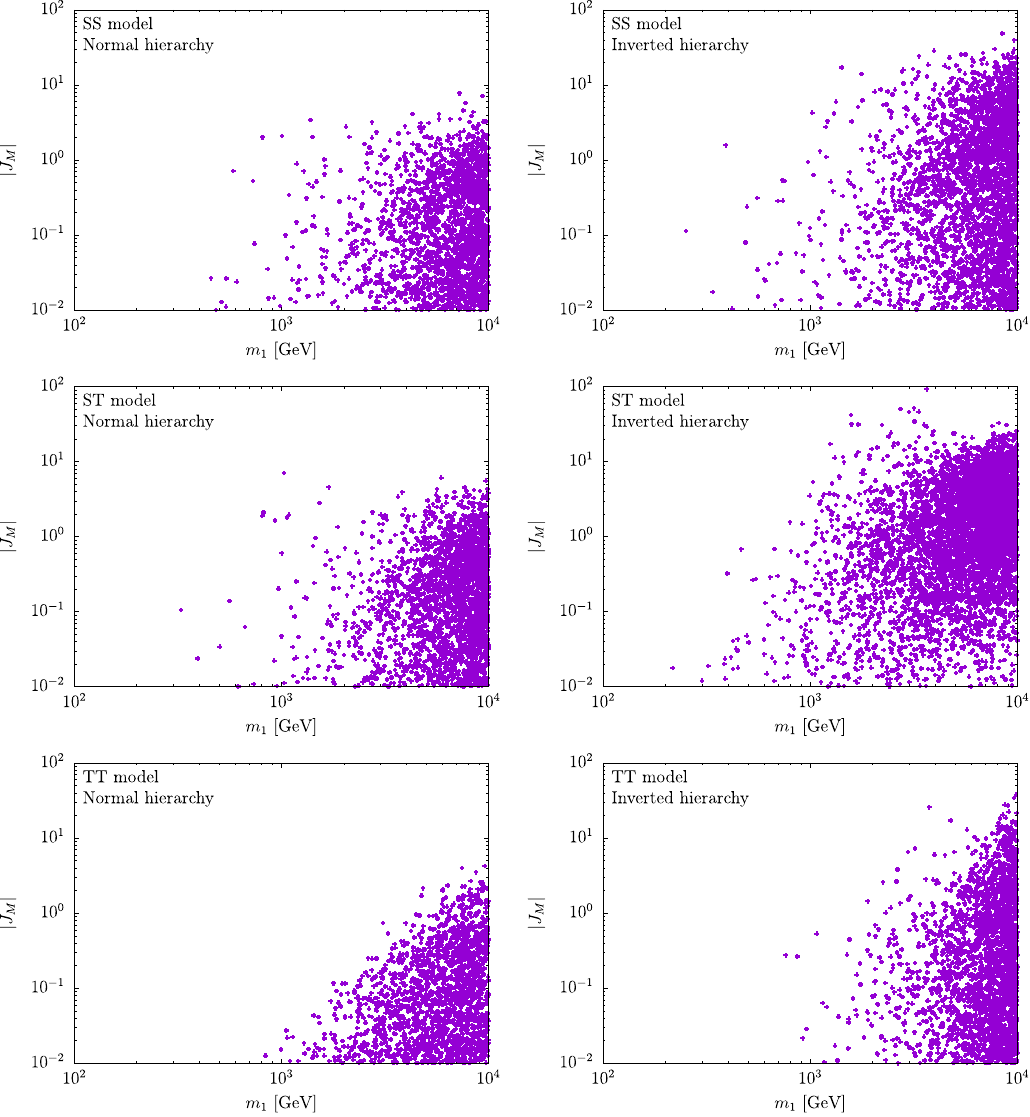
Figure 8 . Magnitude of the Majorana type phase factor J M for normal and inverted hierarchy where the constraints of the neutrino oscillation experiments and the charged LFV are taken into account with the scalar coupling λ 5 = 10 − 10